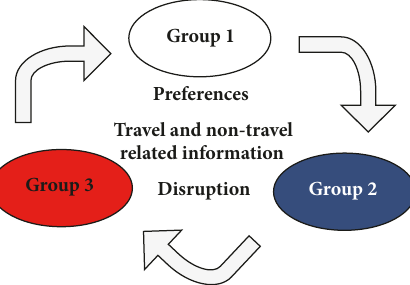
Figure 2: The World Caf´e method was used to discuss three topics (In the Milan workshop, four teams each discussed two